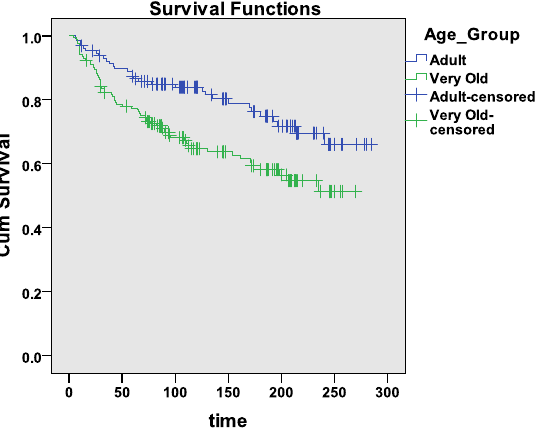
Figure 6. Kaplan Meier Curve of Follow-up months vs. Age Group